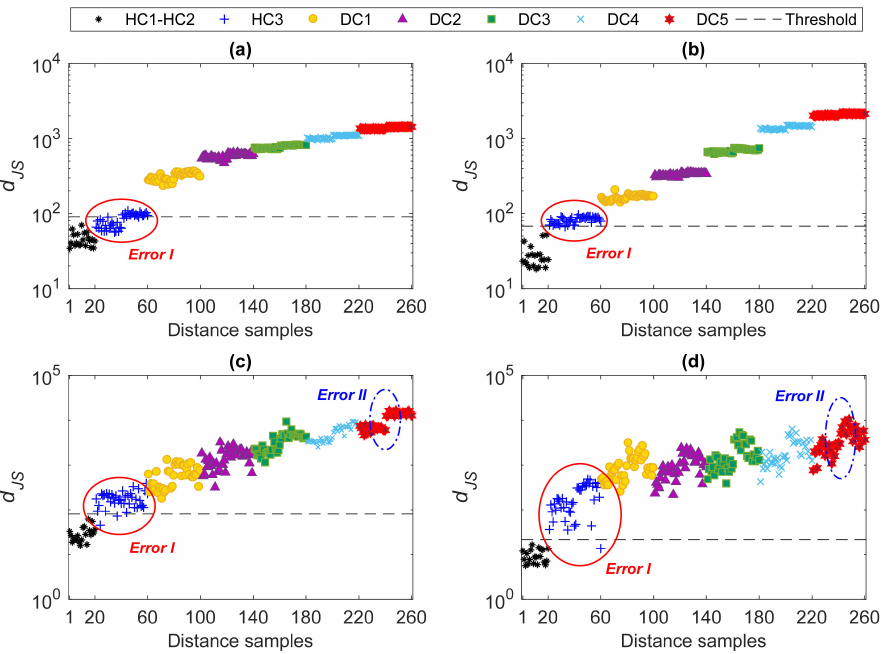
Figure 9. Damage detection by the AR spectrum, classical factor analysis, and JS-divergence: ( a ) Case 1, ( b ) Case 2, ( c ) Case 3, ( d ) Case